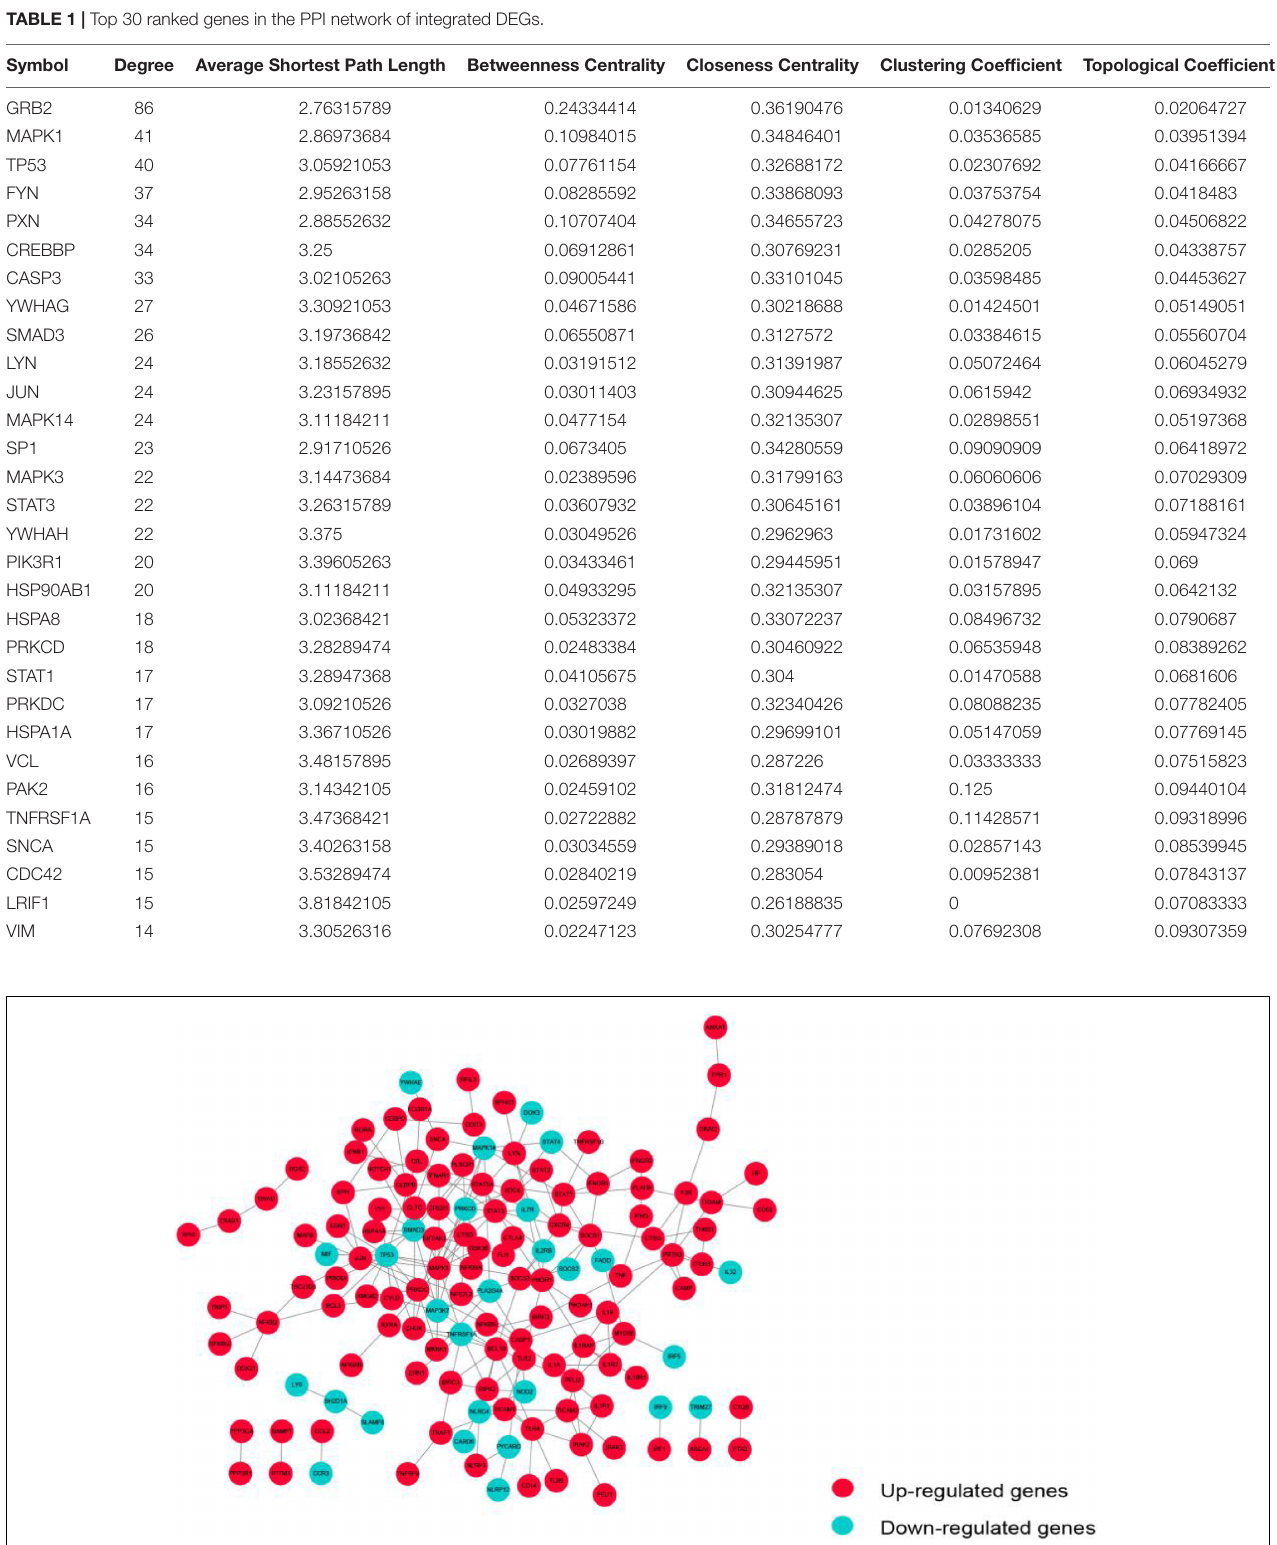
FIGURE 5 | The PPI network of immunosuppression-related crosstalk